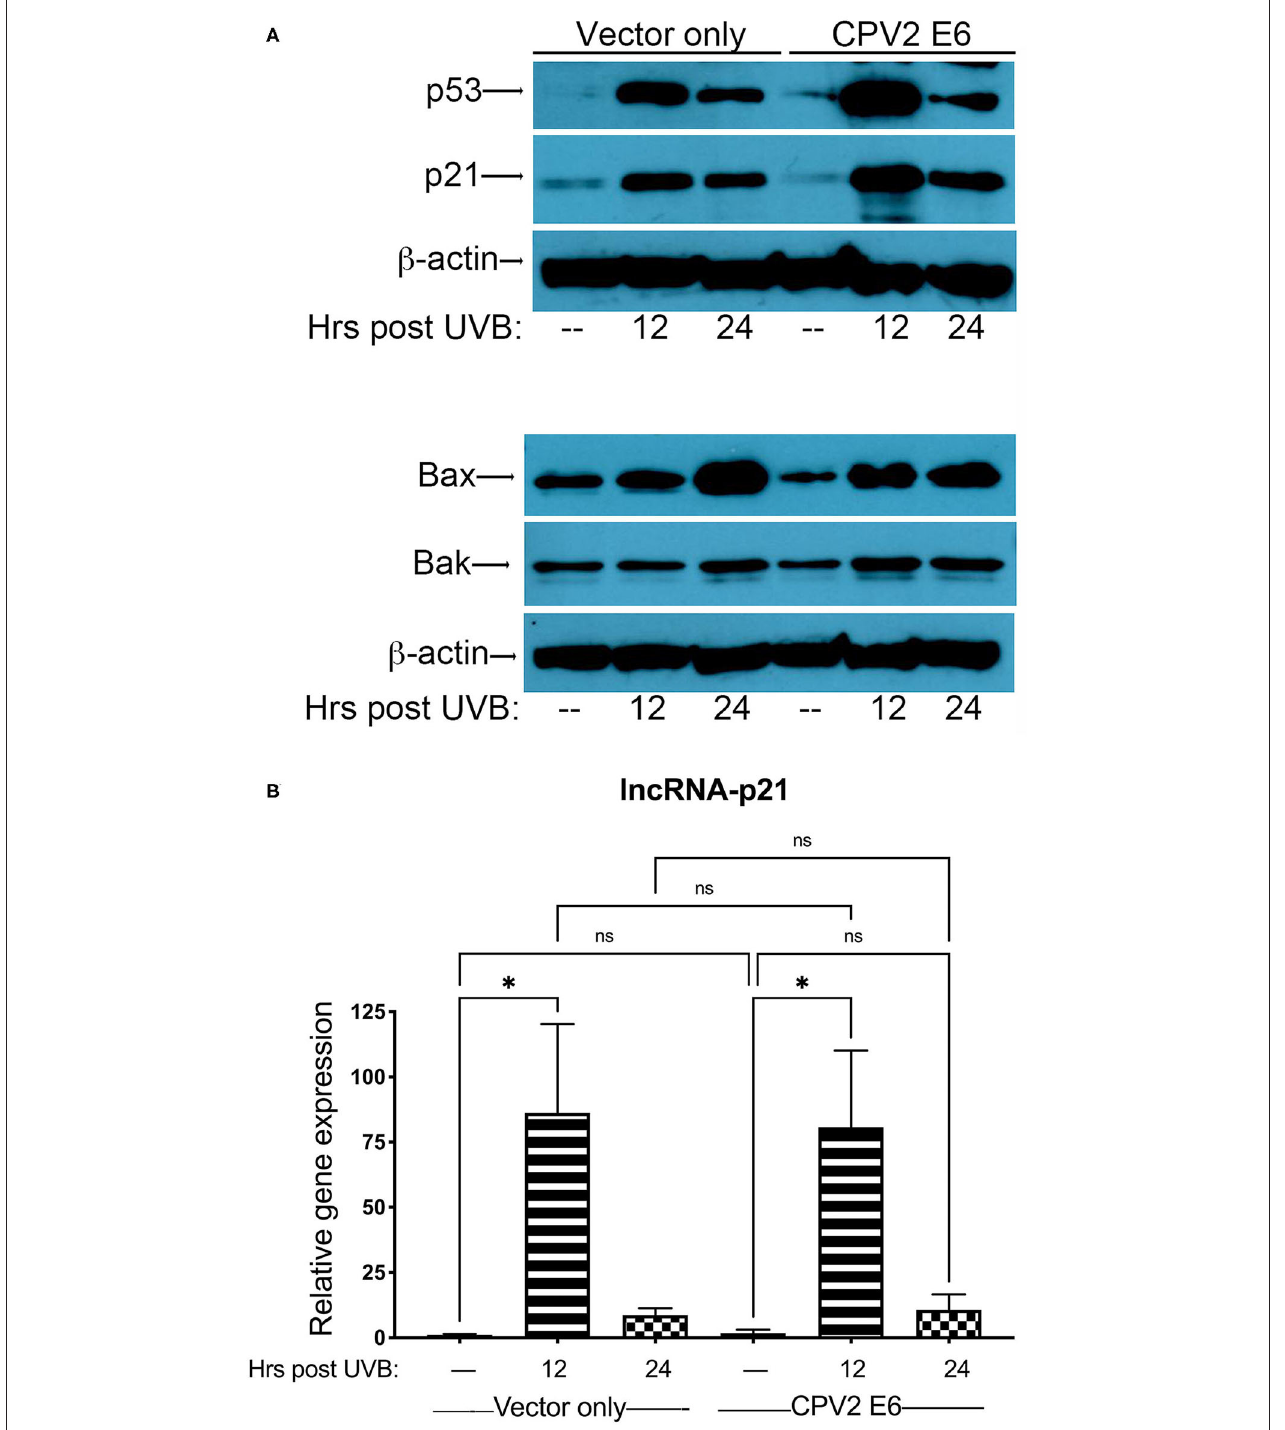
FIGURE 3 | Upregulation of p53 and p53-regulated genes in UVB-exposed canine keratinocytes expressing CPV2 E6. Canine keratinocytes expressing either vector only or CPV2 E6 were exposed to UVB (10 mJ/cm 2 ) and cell lysates collected at 12 and 24h post-irradiation. (A) Proteins were separated by SDS-PAGE and analyzed by immunoblotting with antibodies directed against p53, p21, Bak, and Bax. β -actin was used a loading control. One representative experiment of three is shown. (B) Real time PCR was performed to determine expression of lncRNA-p21. Resulting Cq values were normalized to the Cq value of the reference gene and calibrated to transcript levels in vector only non-UVB exposed cells. Experiments were performed in duplicate and repeated in three independent experiments. One representative experiment of three is shown. Results are expressed as mean ± SD. * p < 0.05.